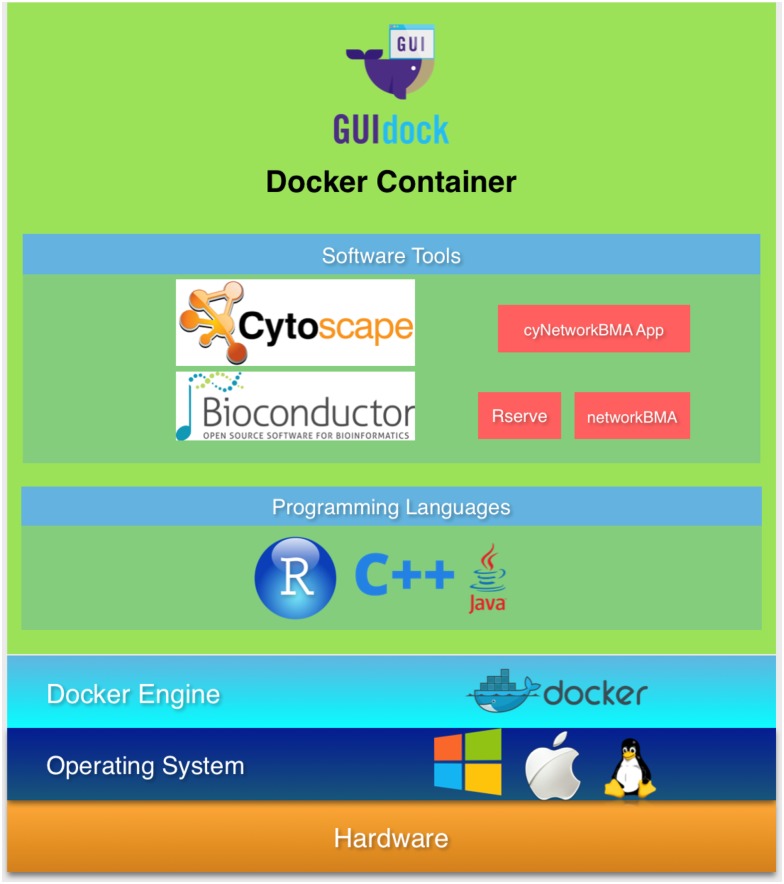
Overview of GUIdock.